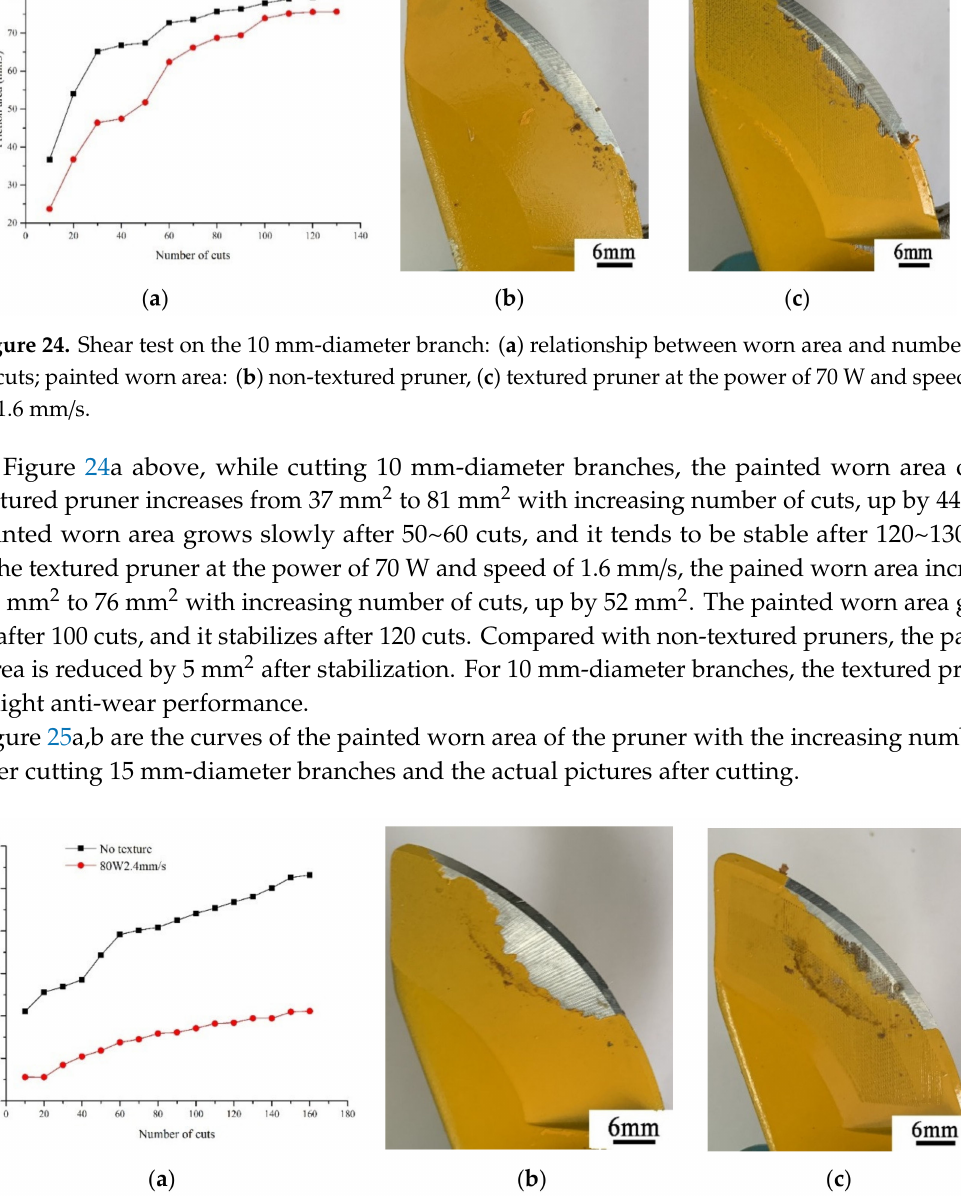
Figure 25. Shear test on the 15 mm-diameter branch; ( a ) relationship between worn area and number of cuts; painted worn area. ( b ) Non-textured pruner, ( c ) textured pruner at the power of 80 W and speed of 2.4 mm /